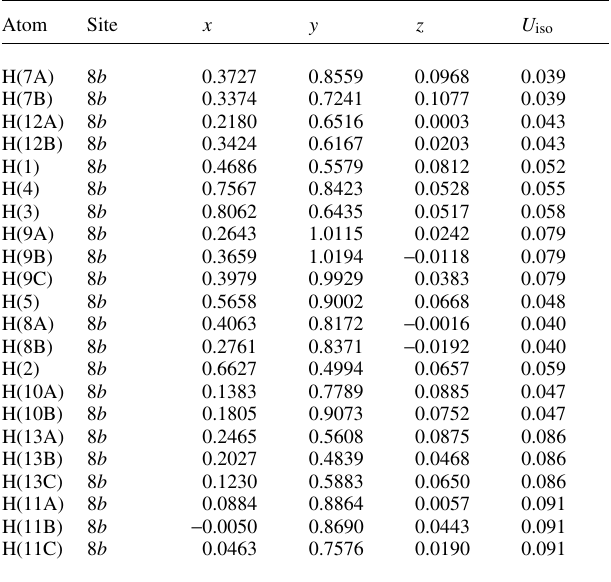
Table 2. Atomic coordinates and displacement parameters (in Å 2 ) .